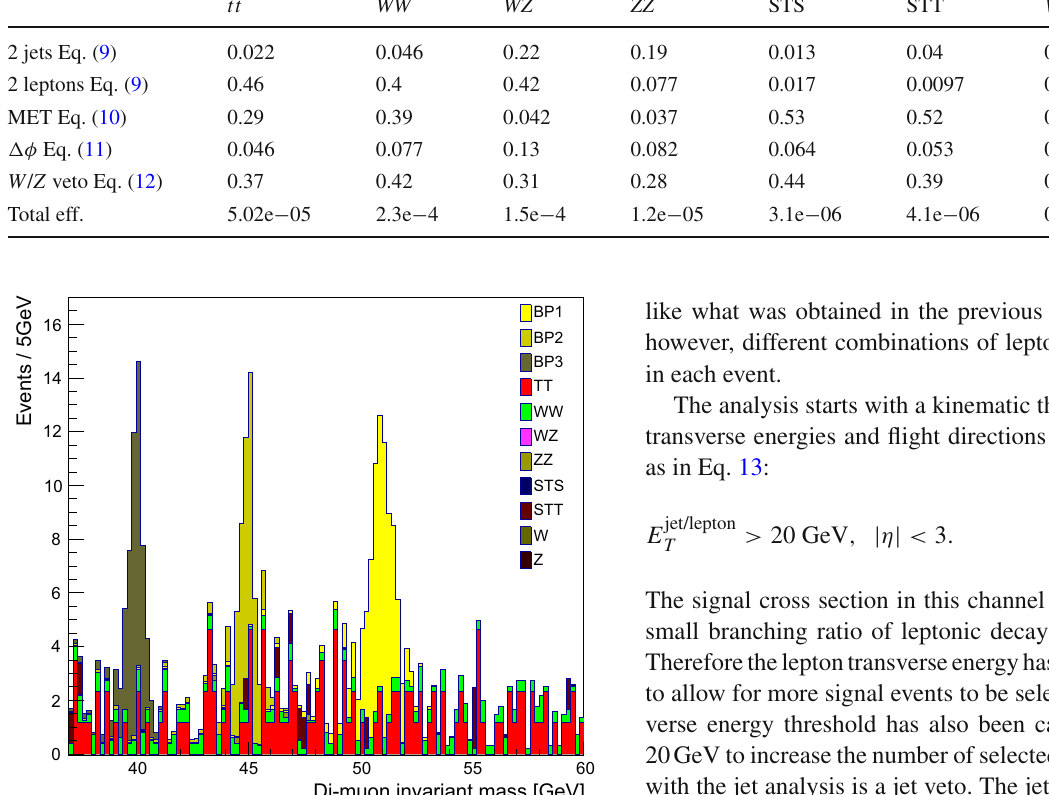
cuts which maximize the signal significance. Based on these results, a 5 σ discovery is possible in the area of 300fb − 1 integrated luminosity.